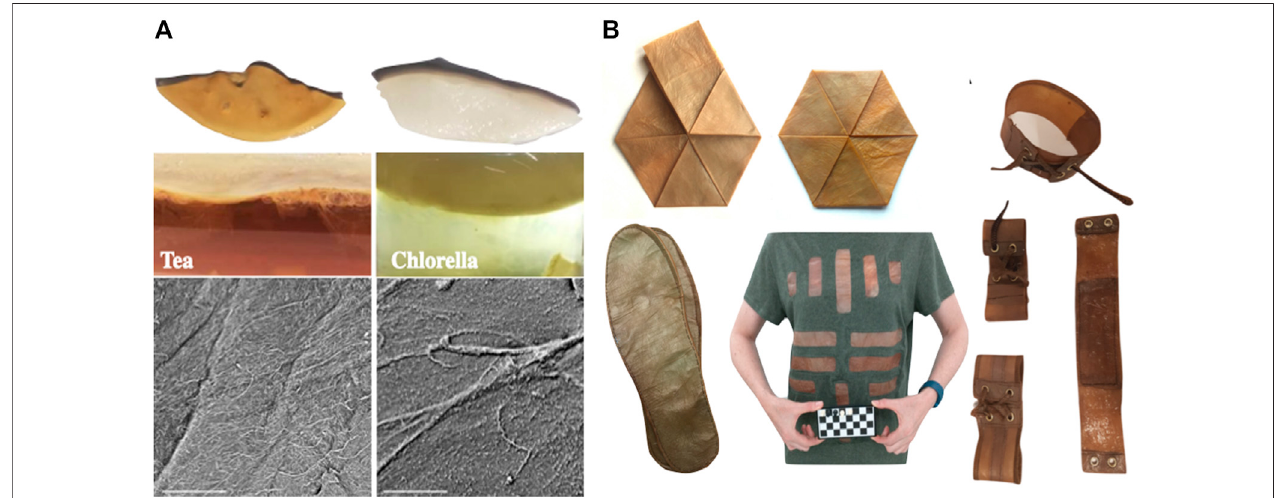
FIGURE 4 | Bacterial nanocellulose can be used for clothes in space. (A) The traditional substrate for KMC, a tea, must be replaced by alternative components, e.g., photosynthetic algae, for biofabrication of cellulose. The comparison between two types of KMC cultures: (left) grown on tea, and (right) grown on algae. Hydrogel bacterialcelluloseissimilarinchemicalcompositionbutphysicalpropertiesareslightlydifferent.Nanocellulosegrownonalgaeextractismuchsofterandmorepronefor damage.Scanningelectronmicroscopeimagesrevealtheultrastructureofnanocellulose fi laments.Scalebar50microns(modi fi edafterSuchan,2020). (B) KMC ’ s material absorbs odours. It can be easily cleaned and sterilised. It folds gently to very compact volumes. Folding does not implicate changes in structure of the material. Kombucha ’ s cellulose does not generate allergic responses in direct contact with human skin. It makes skin softer and visibly healthier (Ko ł odziejczyk, 2018; Kami ń ski et al.,